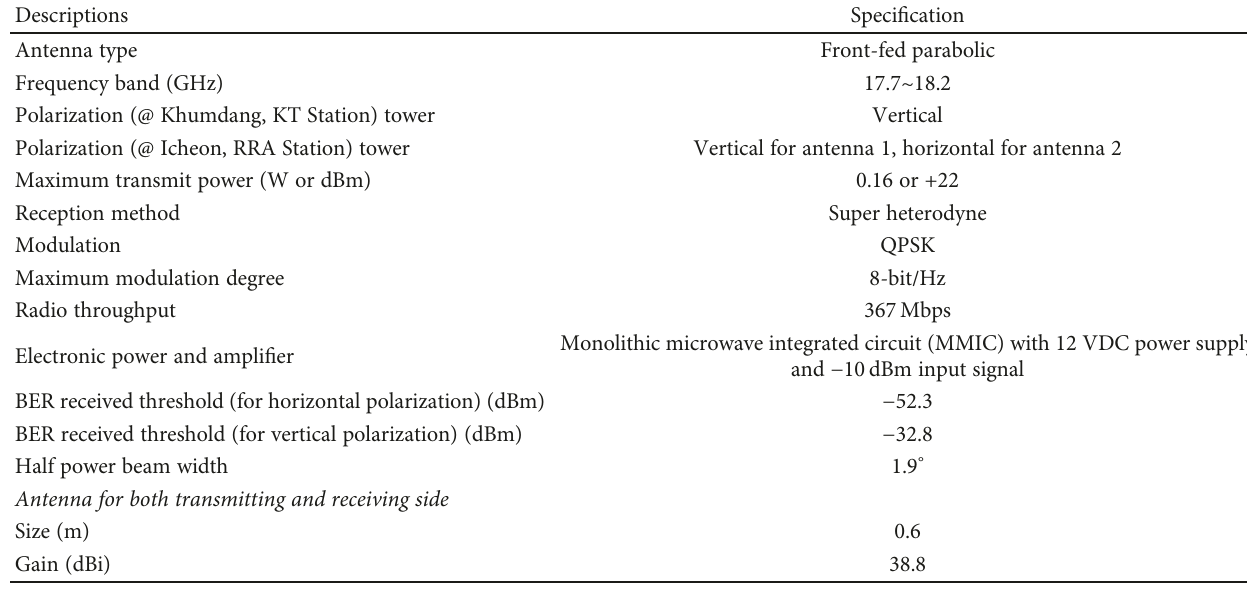
Table 1: The 18 GHz link descriptions [24].